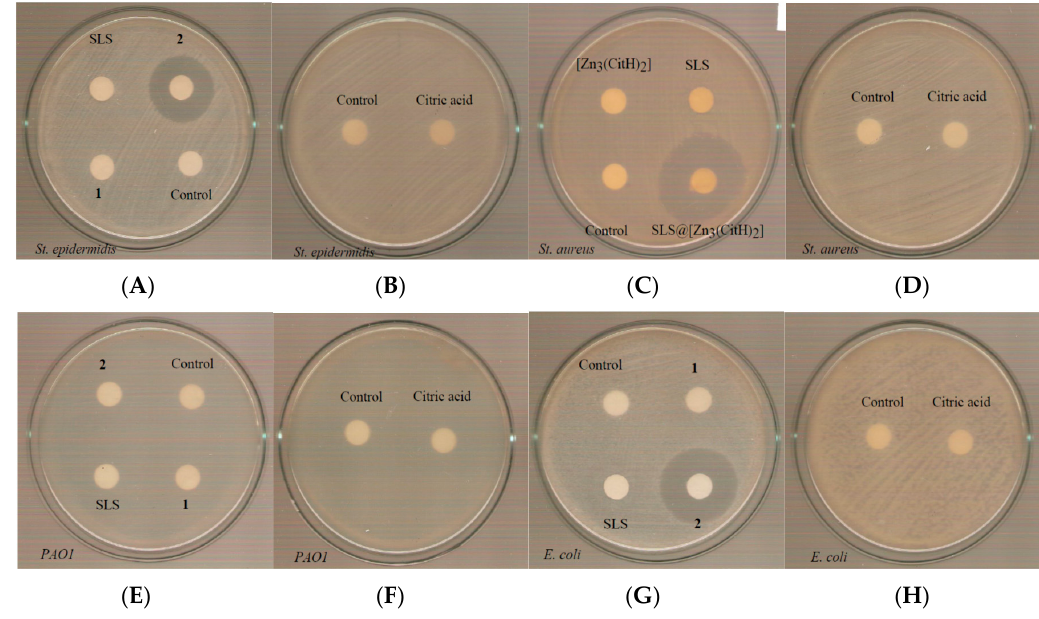
Figure 6. Inhibition zones which were grown in St. epidermidis ( A , B ), St. aureus ( C , D ), PAO1 ( E , F ) and E. coli ( G , H ) for 1 , 2 , SLS, and CitH 4 . E. coli ( G , H ) for 1 , 2 , SLS, and CitH 4